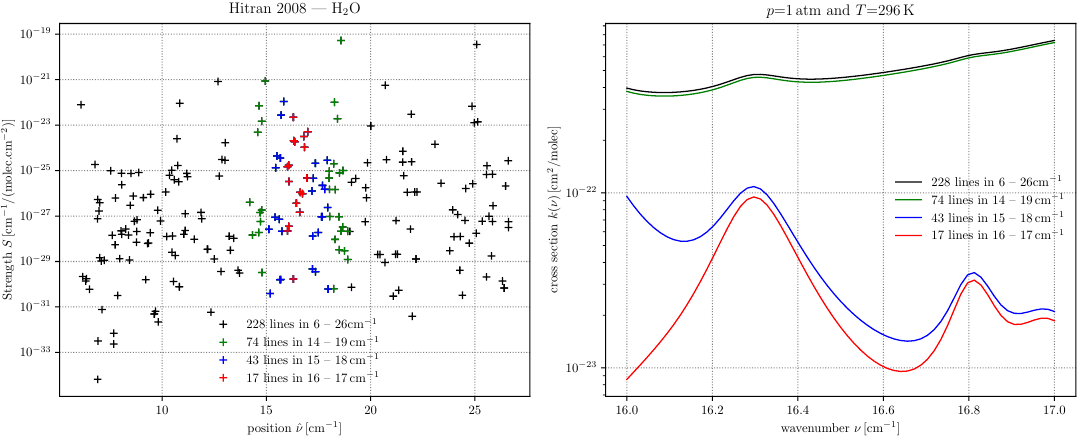
Figure 7. Impact of line wings on H 2 O cross section in the ODIN [83] 501GHz channel. A series of cross sections has been computed taking into account more and more lines to the left and right of the 16 to 17 cm − 1